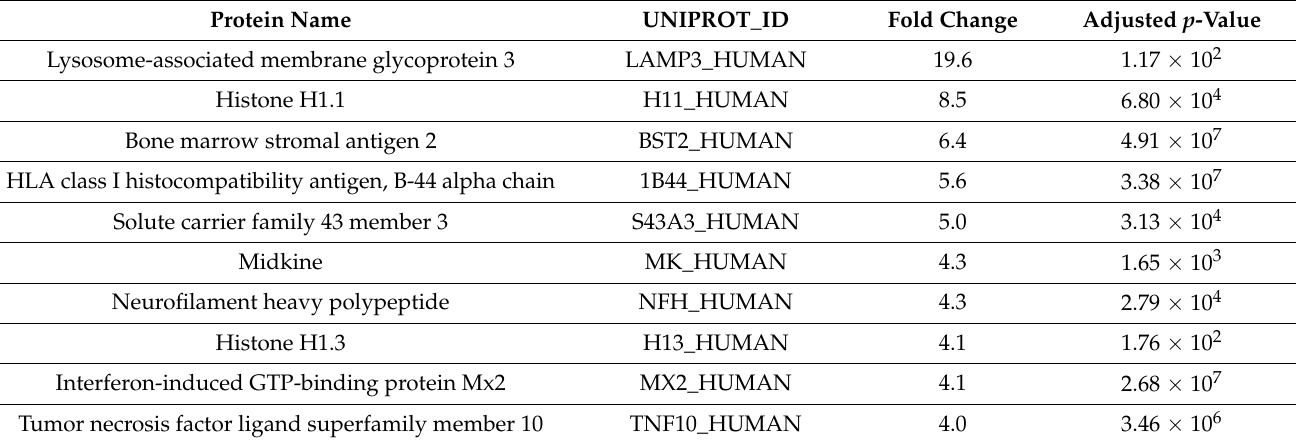
Table 1. List of the top 10 significant proteins most increased in abundance as measured by mass spectrometry-based shotgun proteomics analysis of HEKn cells expressing HPV16 E6 and E7 com- pared to control cells.